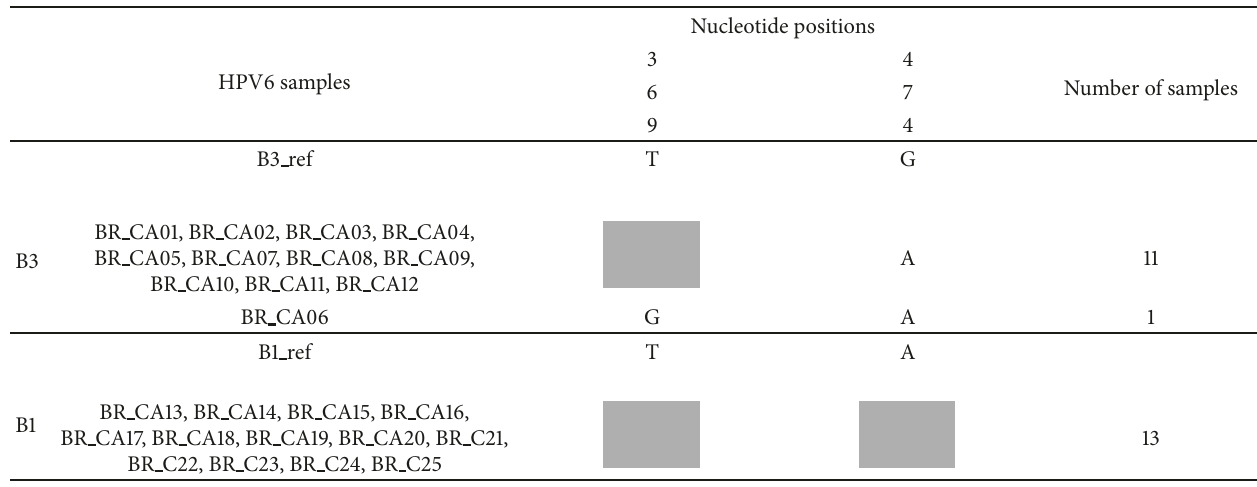
Table 2: Nucleotide alterations in the E6 genes of HPV6 isolates. Genomic positions are indicated in the upper part of the table, and the mutations are vertically indicated. Conserved nucleotides in relation to the reference sequence are shown in gray. The column “Number of samples” indicates the number of patients in which the isolates are identical to the specified variant.